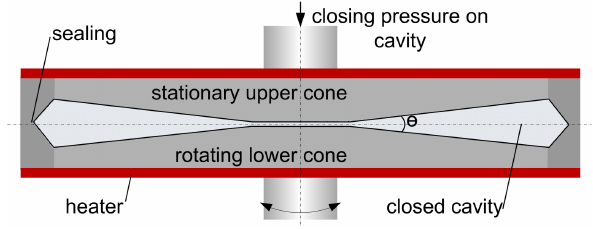
Figure 1: Schematic illustration of the closed cavity rheometer cell used for rheological characterization.